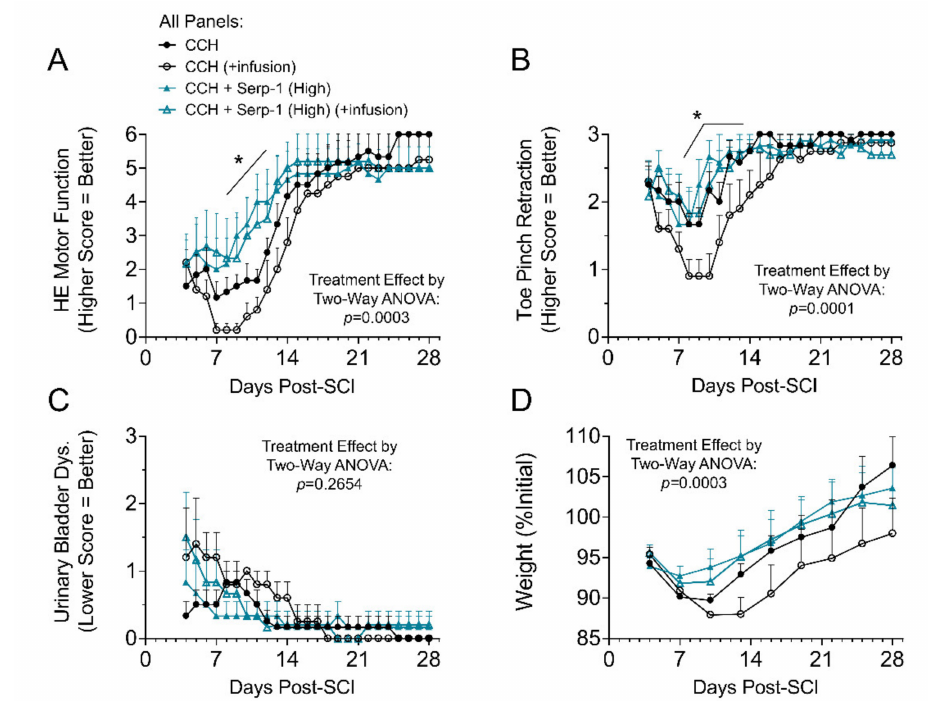
Figure 1. Clinical evaluation of rats after spinal cord injury (SCI) treated. ( A ) Hind end (HE) motor function scores for SCI rats treated with 50 µ L chitosan-collagen gel only (chitosan) or 50 µ L gel with 100 µ g Serp-1 (chitosan-Serp-1 high). Higher score indicates better function; ( B ) Average toe pinch retraction scores from both left and right toes. Higher score indicates better function; ( C ) Urinary bladder dysfunction scores. Lower score indicates better function; ( D ) Weight tracking of rats post SCI, normalized to initial weights on the day of injury. Statistics calculated by two-way ANOVA with Fisher’s LSD of Serp-1 chitosan-collagen hydrogels (CCH) vs. CCH both with infusion. The main treatment e ff ect is listed on the figure, while specific day significance is indicated by an asterisk with bar where * p < 0.05. Mean and standard error indicated. Legend given in panel A is identical for all